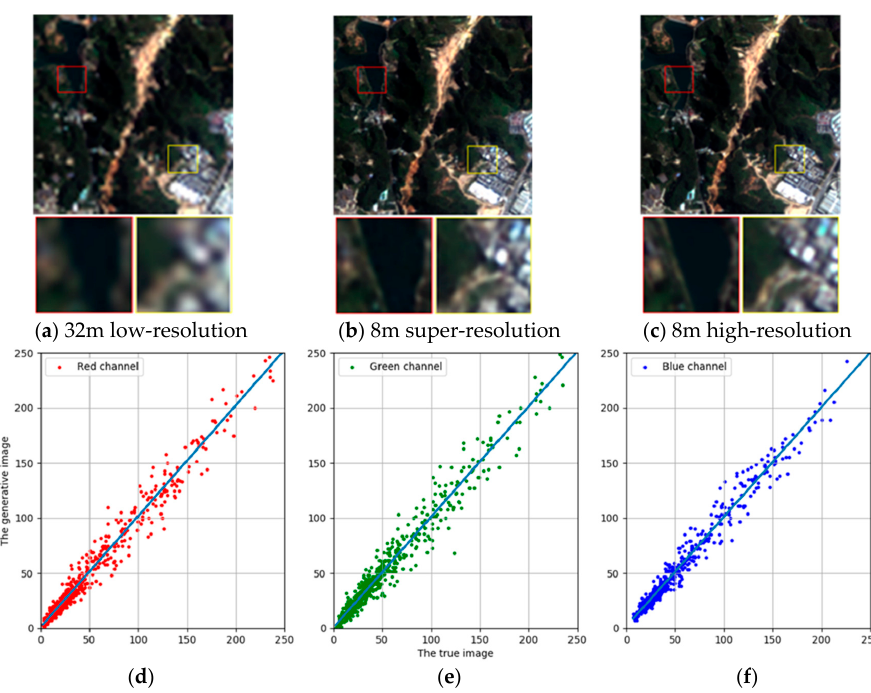
Figure 4. The predicted super-resolution image for our ISRGAN model ( b ) on a GF 1 dataset in Guangdong, compared to the input image ( a ) and the ground truth ( c ). Figures ( d ), ( e ), and ( f ) are 1:1 plots of the Digital Number (DN) value in the red, green and blue bands compared to the ground truth ( c ), with slopes of 1.0063, 1.0032, and 0.9955, respectively.